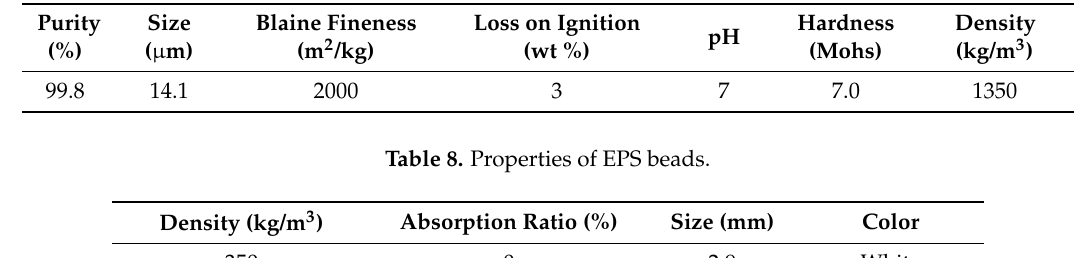
Table 7. Properties of silica powder.